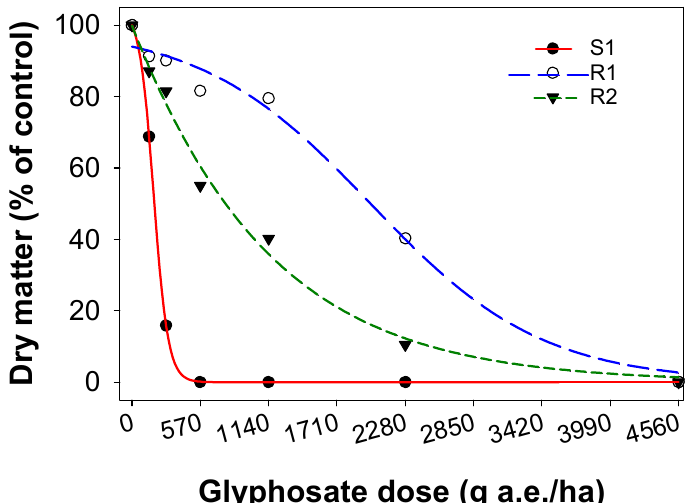
Figure 3. Effect of glyphosate dose on dry matter (percent of non-treated control) of a glyphosate-susceptible (S1) and two glyphosate-resistant (R1 and R2) biotypes of sweet summer grass. A three-parameter sigmoid model fitted to the dry matter data.